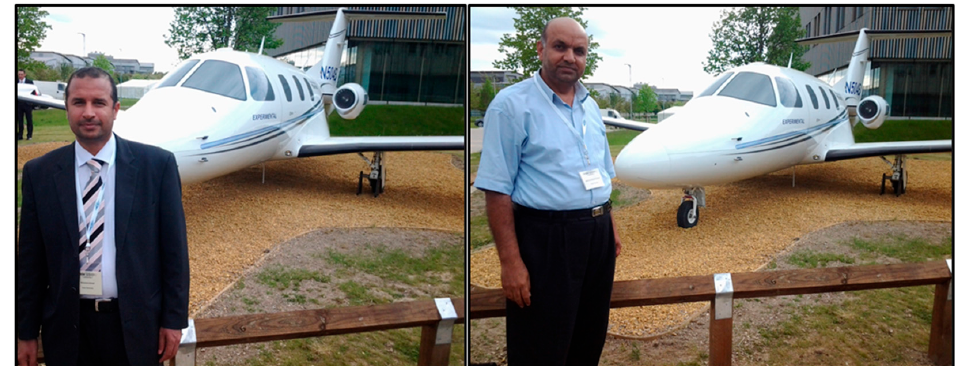
Figure 17. Images for MMZA left and MMES right with the experimental Eclipse 500 business jet presented at TWI–Cambridge as the first aircraft to be manufactured using FSW technology.